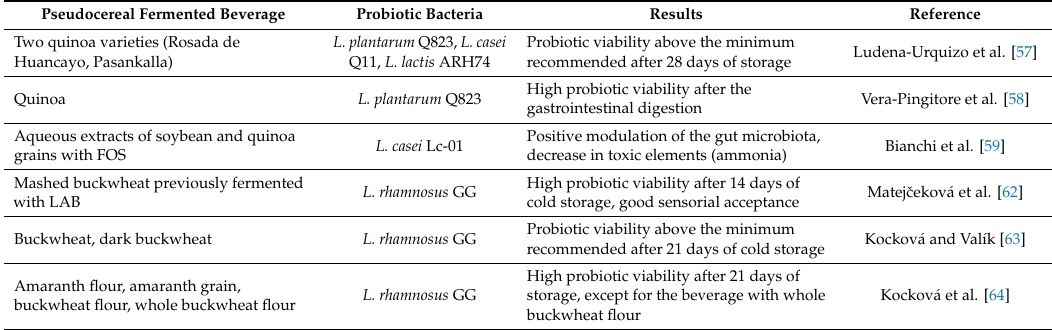
Table 3. Summary of fermented pseudocereal beverages as potential carriers for bioactive compound, probiotic, and prebiotic delivery to the gut. Pseudocereal Fermented Beverage Probiotic Bacteria Results